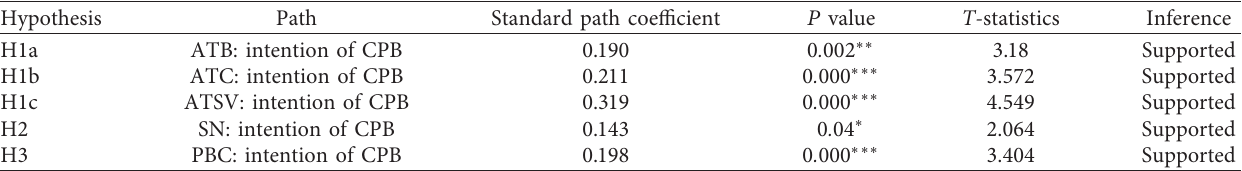
Table 6: Results of hypotheses testing.